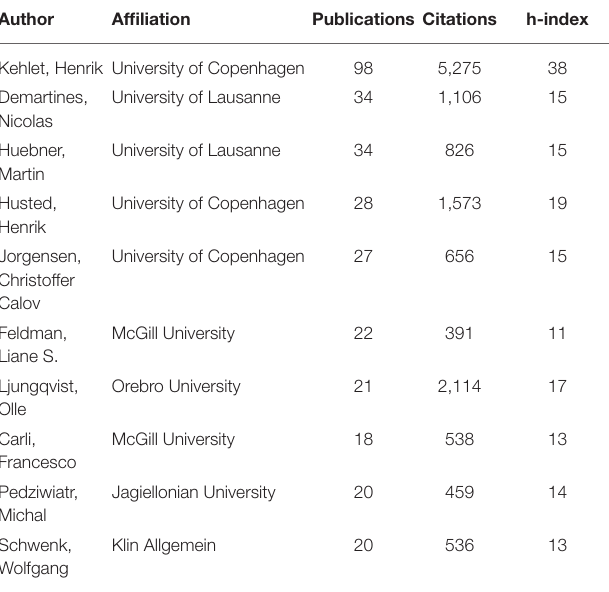
TABLE 2 | Top 10 authors with the greatest number of publications.